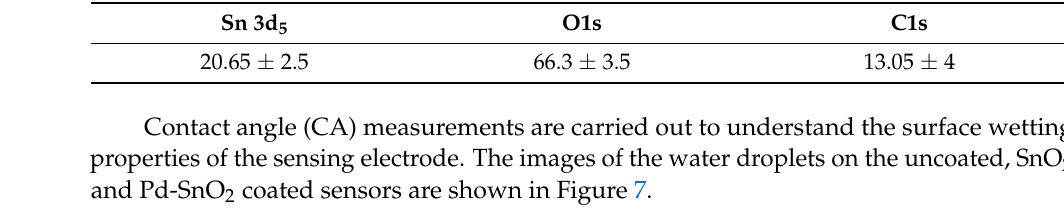
Table 3. Atomic concentrations (%) of SnO 2 pixels transferred by LIFT at 100 mJ/cm 2 .